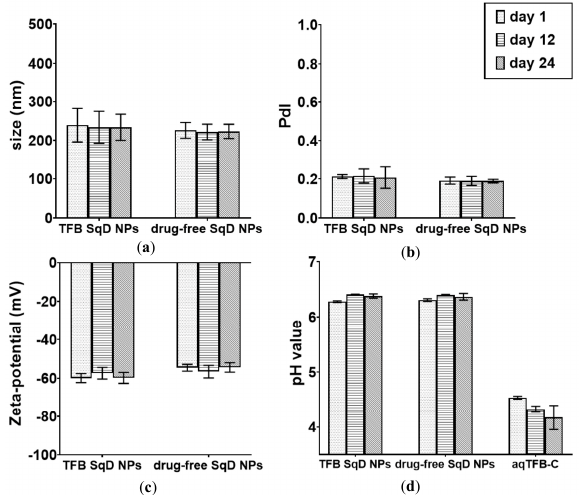
Figure 2. Colloidal stability of TFB SqD NPs, drug-free SqD NPs, and aqTFB-C solution at 4 °C, over a 24-day period, investigated by DLS, ELS, and pH measurements. ( a ) Hydrodynamic diameter (nm), ( b ) polydispersity index, ( c ) zeta-potential (mV), and ( d ) pH-value. Results are presented as mean ± SD.